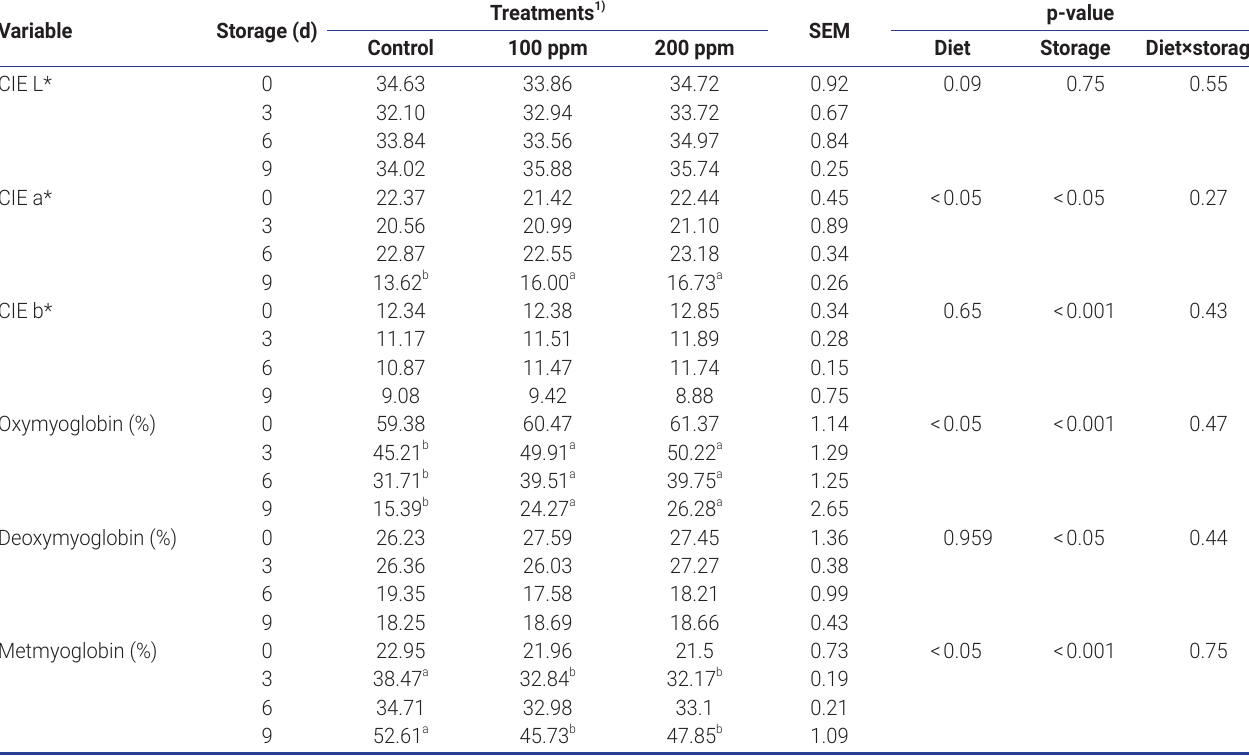
Table 6. Effect of rumen protected γ-aminobutyric acid supplementation on meat color and relative myoglobin concentration (%) of longissimus lumborum from Hanwoo steers during refrigerated storage